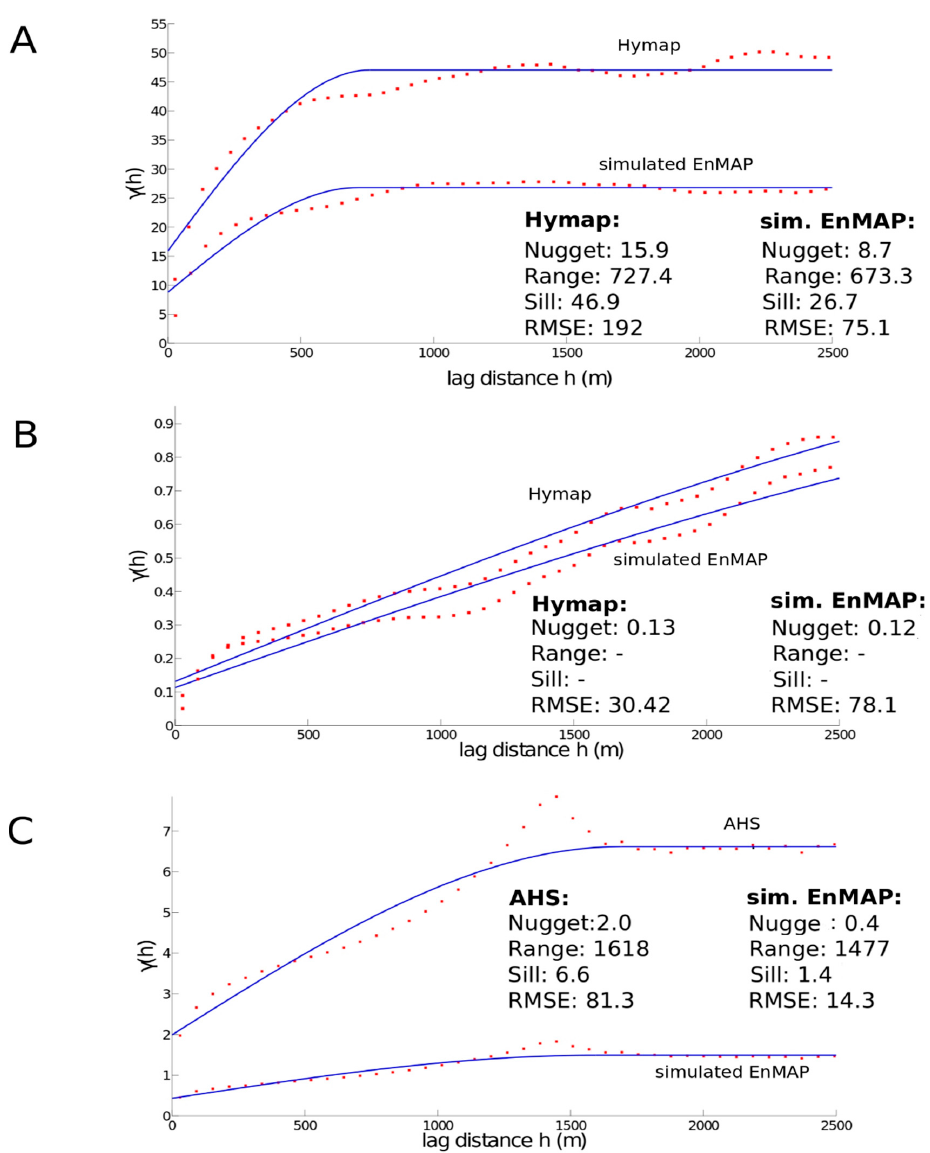
Figure 7. Semivariograms for: ( A ) Iron oxide, Cabo de Gata test site; ( B ) Clay, Cabo de Gata test site; and ( C ) SOC content, Luxembourg test site. The descriptive parameters are included in the